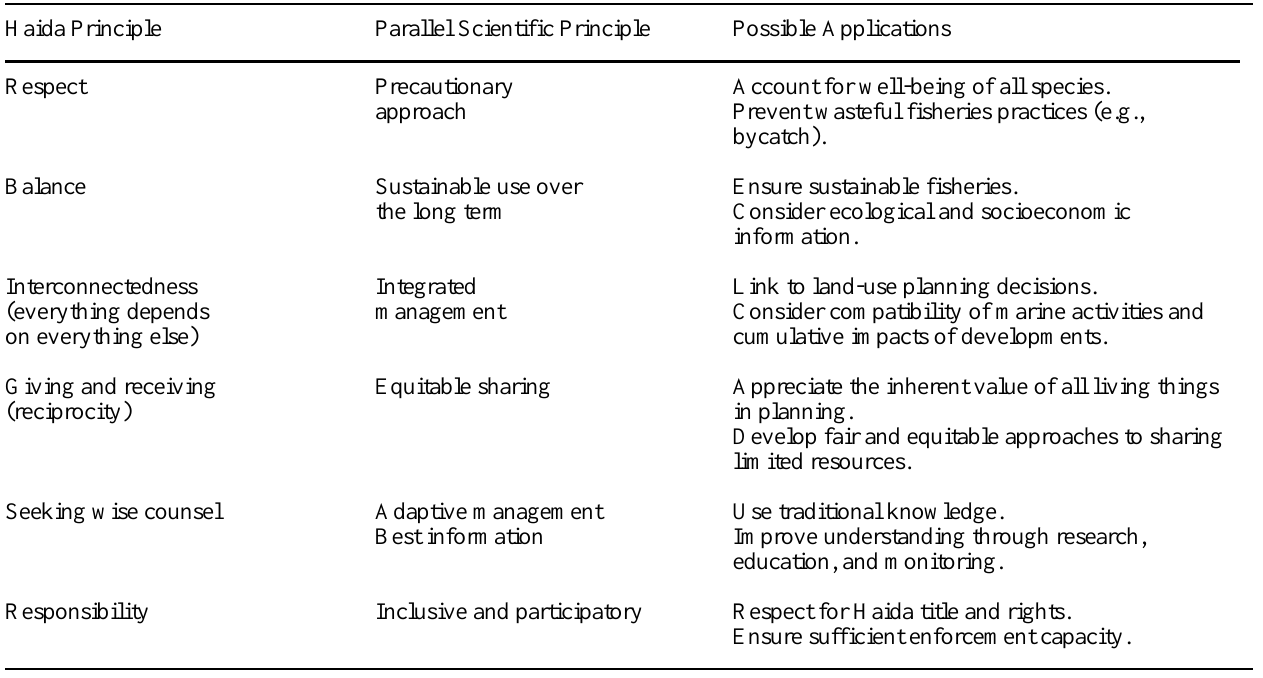
Table 1 . Comparison of Haida and scientific principles for ecosystem-based